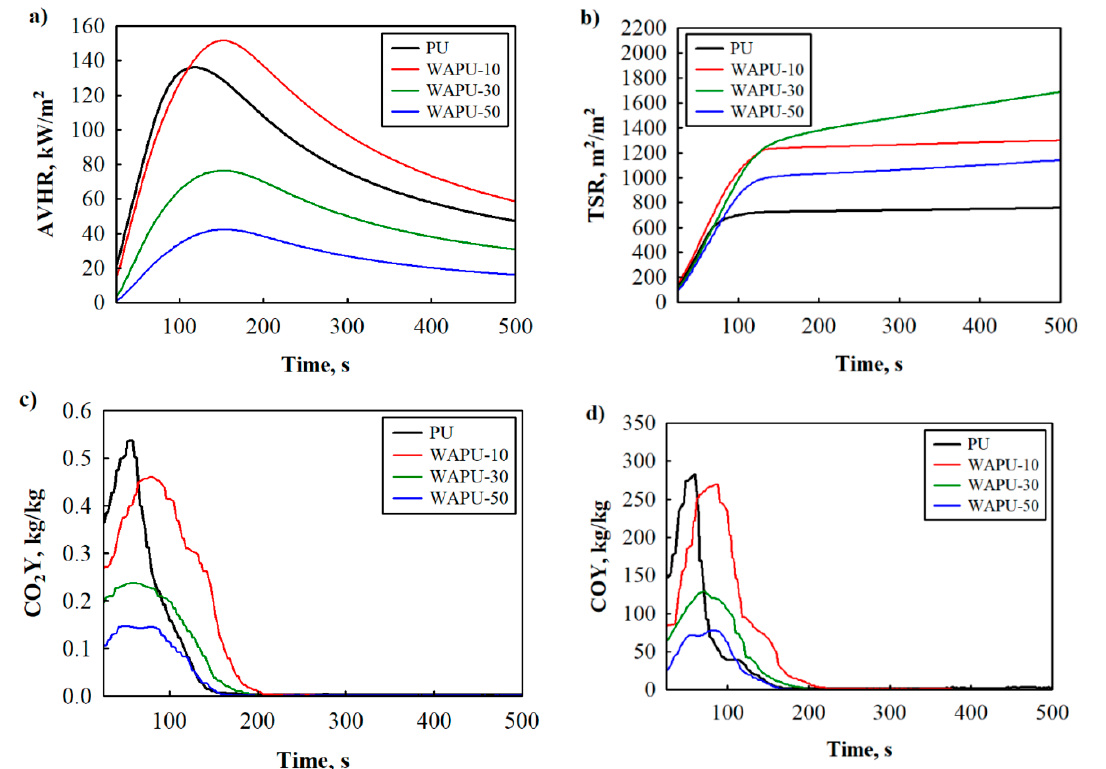
Figure 3. Flame retardancy of PU and WAPU foams: ( a ) average heat emission (AVHR); ( b ) total smoke released (TSR); ( c ) CO2Y and ( d )